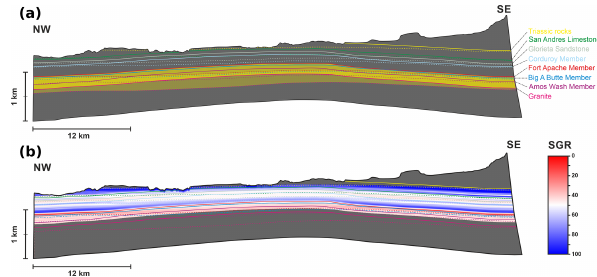
Figure 5. (a) Allan diagram (Allan, 1989) of the Coyote Wash Fault: dashed lines represent the hangingwall; straight lines repre- sent footwall cut-off lines. Yellow-coloured horizons are the main reservoirs (Amos Wash Member, Big A Butte Member and Fort Apache Member of the Permian Supai Formation). (b) Shale gouge ratio plotted onto the Coyote Wash Fault plane. SGR indicates that for most of the fault phyllosilicate-rich fault rocks are likely (SGR >